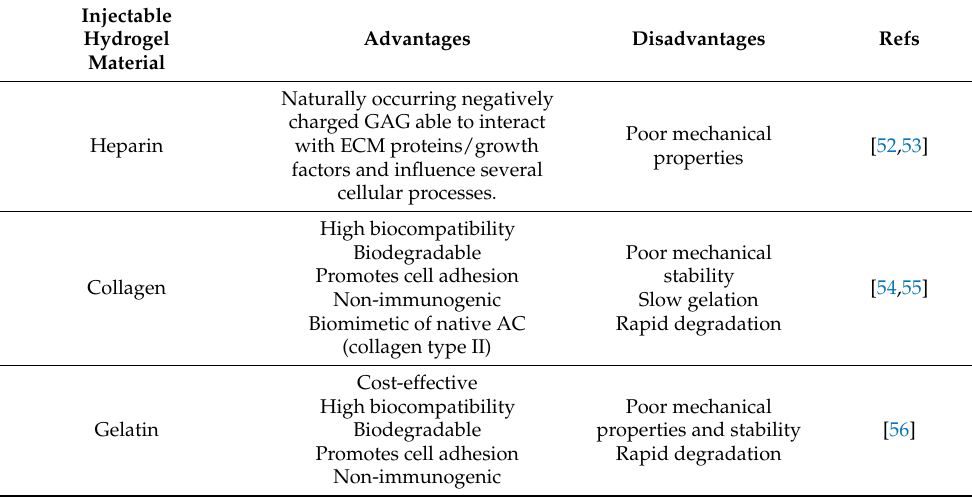
Table 1. Examples of hydrogels materials used as injectable systems for CTE